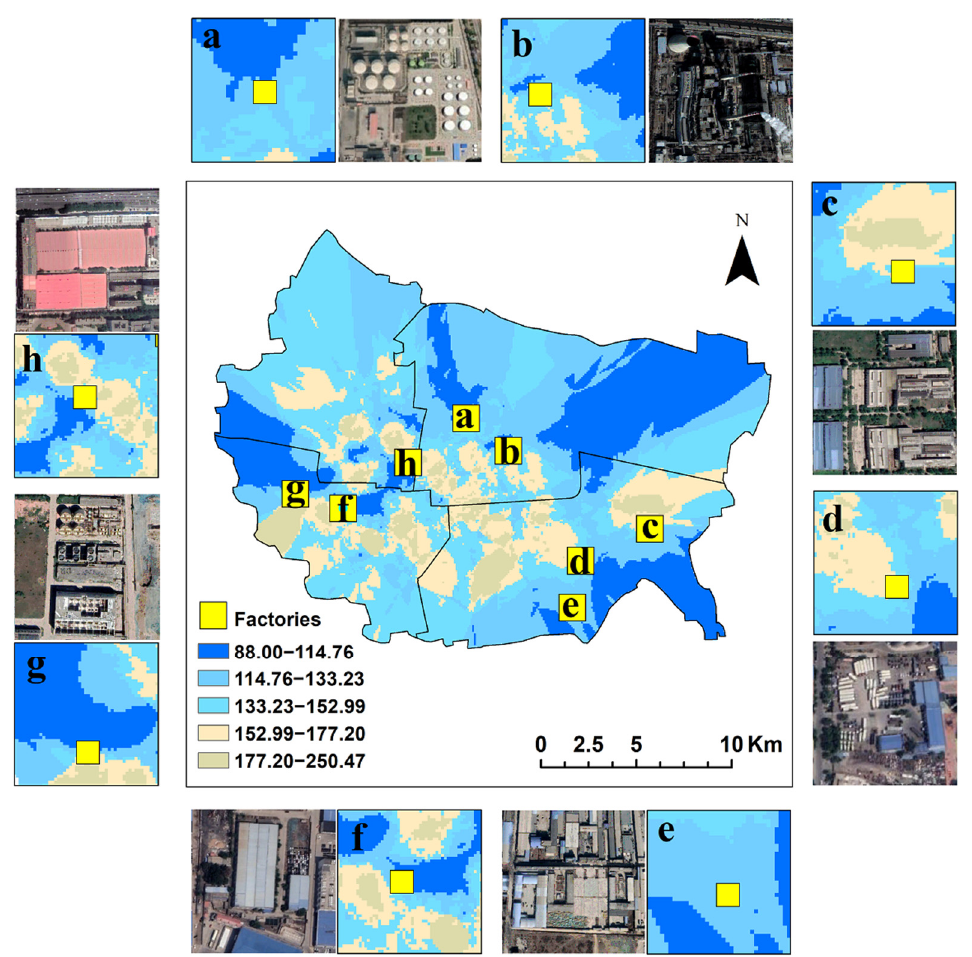
Figure 6. Examples of factories: ( a ) Chemical factory; ( b ) steel factory; ( c ) pharmaceutical factory; ( d ) building materials factory; ( e ) machinery factory; ( f ) paint factory; ( g ) electrochemical plant; ( h ) food factory.